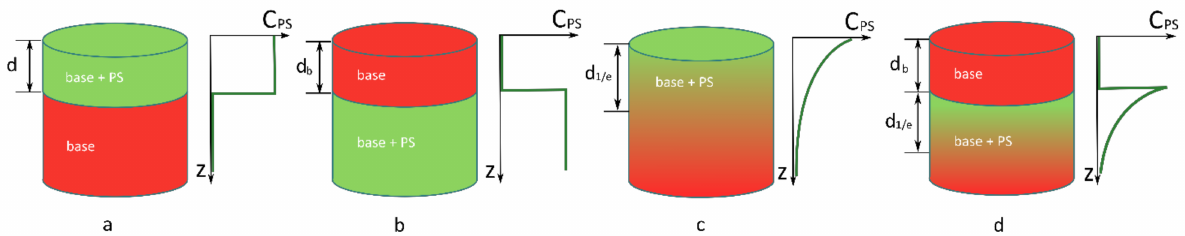
Figure 2. Schematics of the considered cases of PS distribution in the tissue mimicking basic examples of topical or systemic PS administration: ( a ) PS is distributed uniformly in the upper layer of biotissue of thickness d; ( b ) PS is distributed uniformly within the semispace below the biotissue layer of thickness d b ; ( c ) PS concentration exponentially decreases in depth with the 1/e decay depth d 1/e ; and ( d ) a PS layer with an exponentially decaying concentration with the scale d 1/e is covered by the biotissue layer of thickness d b . The dependence C PS ( z ) illustrates the PS concentration in-depth